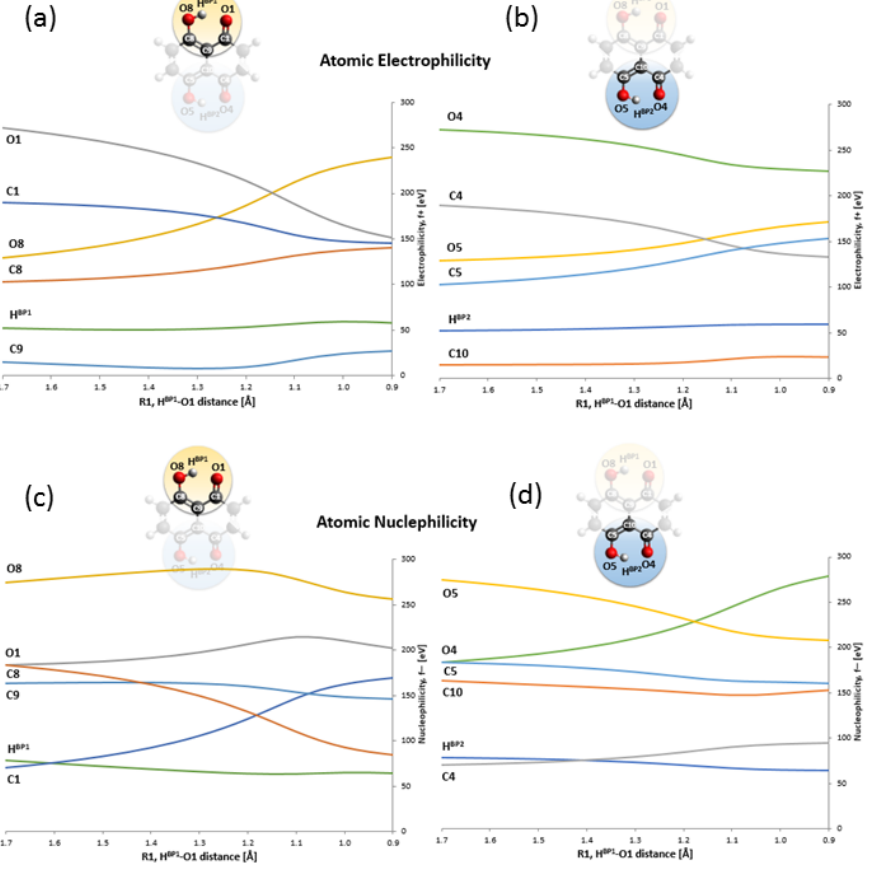
Figure 5. Atomic electrophilicity and nucleophilicity evolution as a function of the intramolecular hydrogen bond distance changes. Atomic electrophilicity for the ( a ) O8...O1 and ( b ) O5...O4 bridge, and atomic nucleophilicity for the ( c ) O8...O1 and ( d ) O5...O4 bridge are